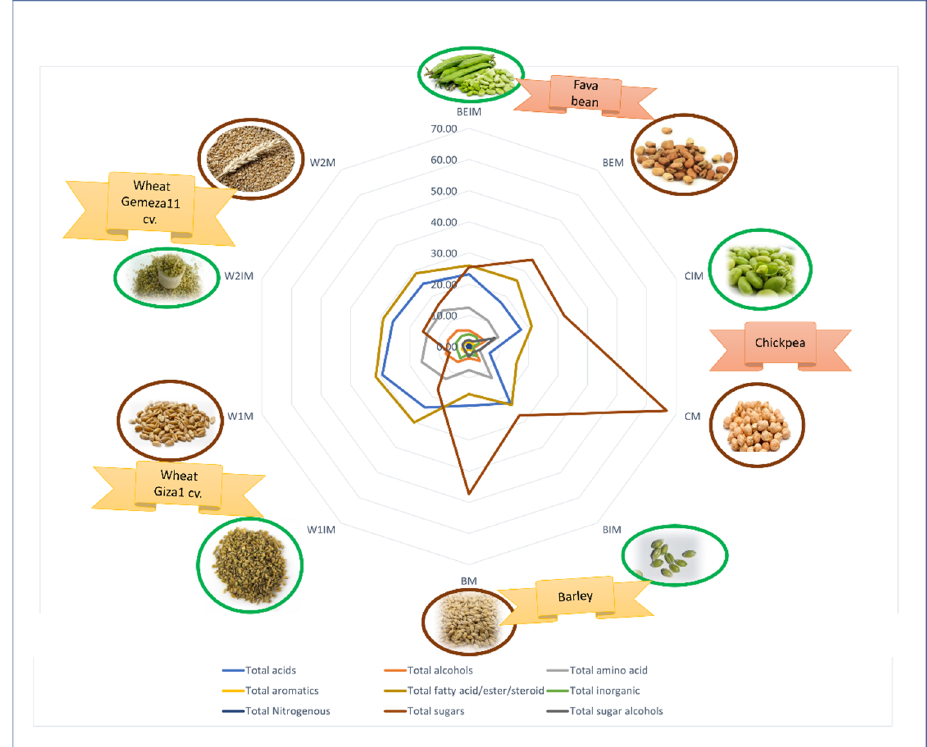
Figure 6. Radar plot of major metabolite classes contributing to the discrimination between investigated specimens, i.e., total acids, total aromatics, total nitrogenous, total alcohols, total fatty acid/ester, steroid, total sugars, total amino acids, total inorganic and total sugar alcohols, in investigated seeds. The figure demonstrates that total sugars are markers for CM and BM, total fatty acid/ester and steroids for BM and BIM, total acids for BIM, total amino acids for BIM, while total sugar alcohol is a marker for CIM. The corresponding sample codes follow those listed in Table 1.